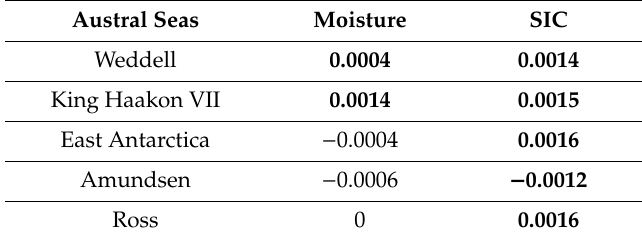
Table 2. Trend of the mean monthly moisture sink and the SIC for each austral sea obtained with the non-parametric test from Mann-Kendall with Sen’s slope. Statistically significant values at the level of 95% are highlighted in bold.